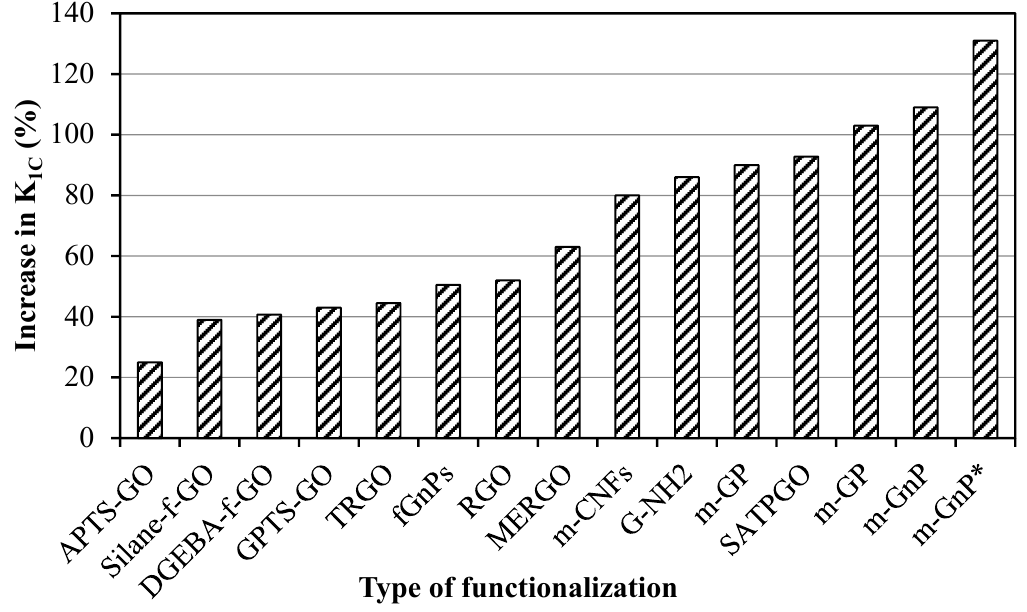
Figure 7. The maximum improvement in K 1C as a function of functionalization method. (See references in Table 1).